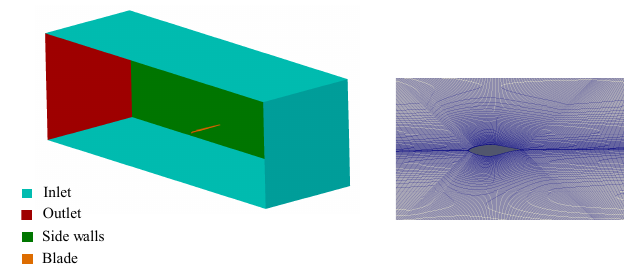
Figure 13. Left: fluid domain. Right: fluid mesh in the vicinity of the blade.